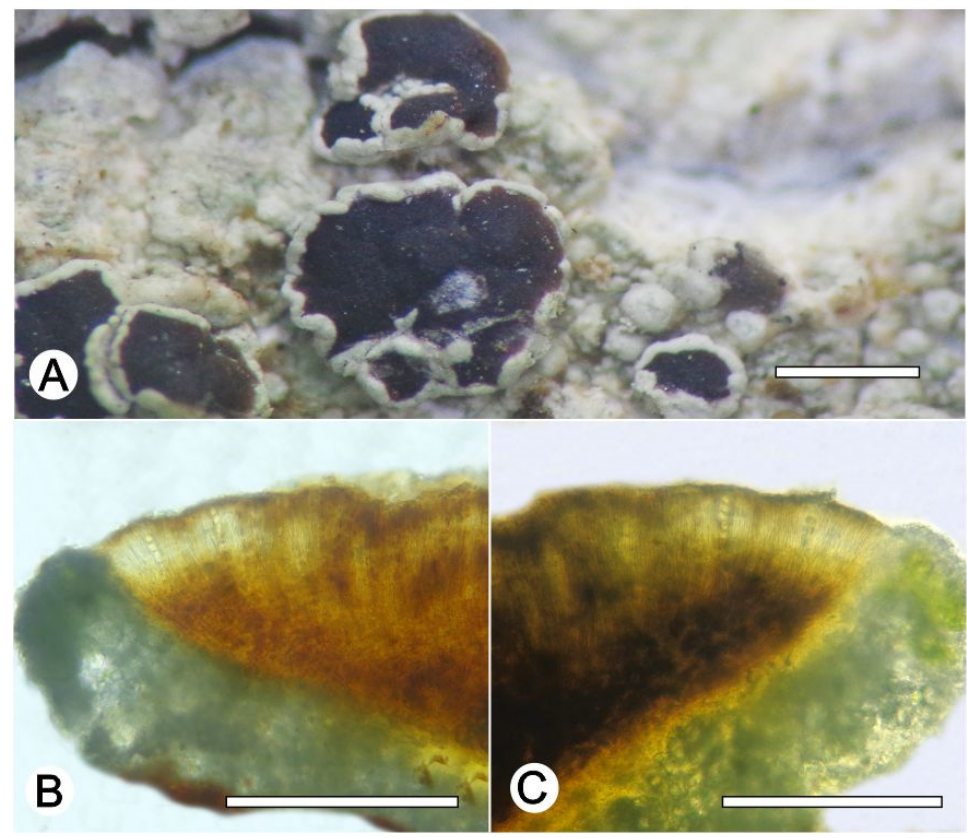
Figure 5. Lecanora irregularicrocea sp. nov. ( A ) Thallus with ascomata (holotype ISE-38135); ( B ) Apothecial section in water (holotype ISE-38135); ( C ) Apothecial section after KOH treatment (holotype ISE-38135). Scale bars: ( A ), 1 mm; ( B , C ), 100 µm.